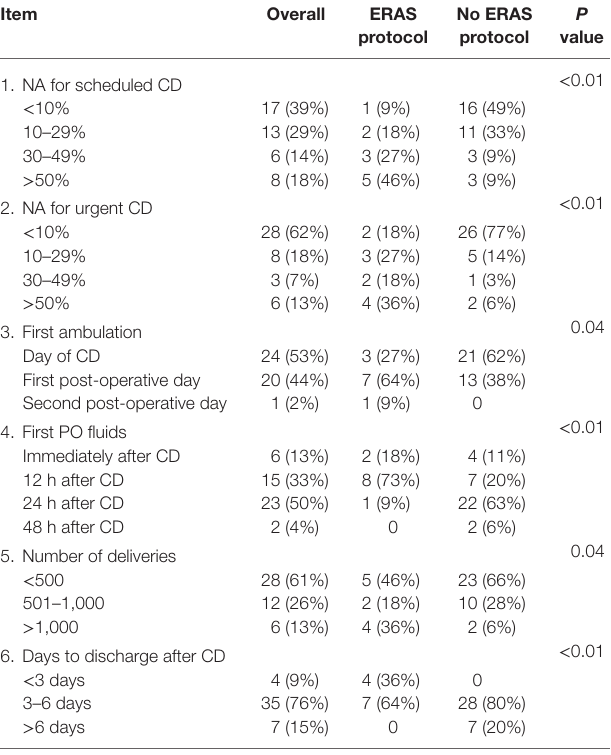
Table 3 | Survey items with differing responses from institutions with and without ERAS protocols.